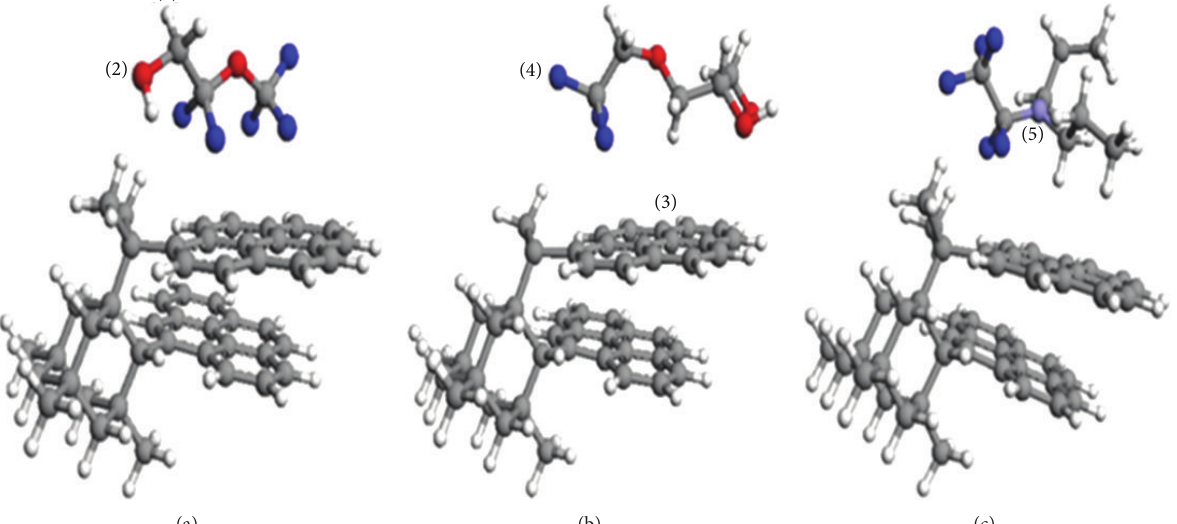
Figure 5: The relaxed PFPE-DLC dimers for (a) Z-dol, (b) Z-tetraol, and (c) DDPA. White = hydrogen, red = oxygen, grey = carbon, blue = fluorine, and violet = nitrogen.